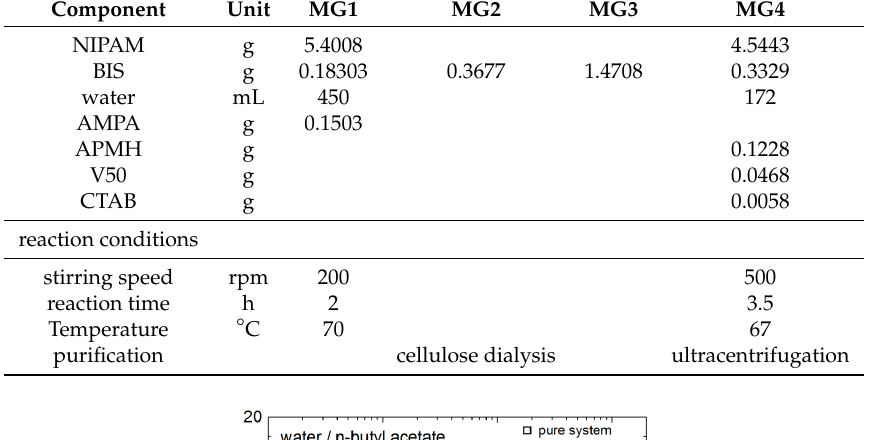
Table A2. Microgel synthesis parameters.